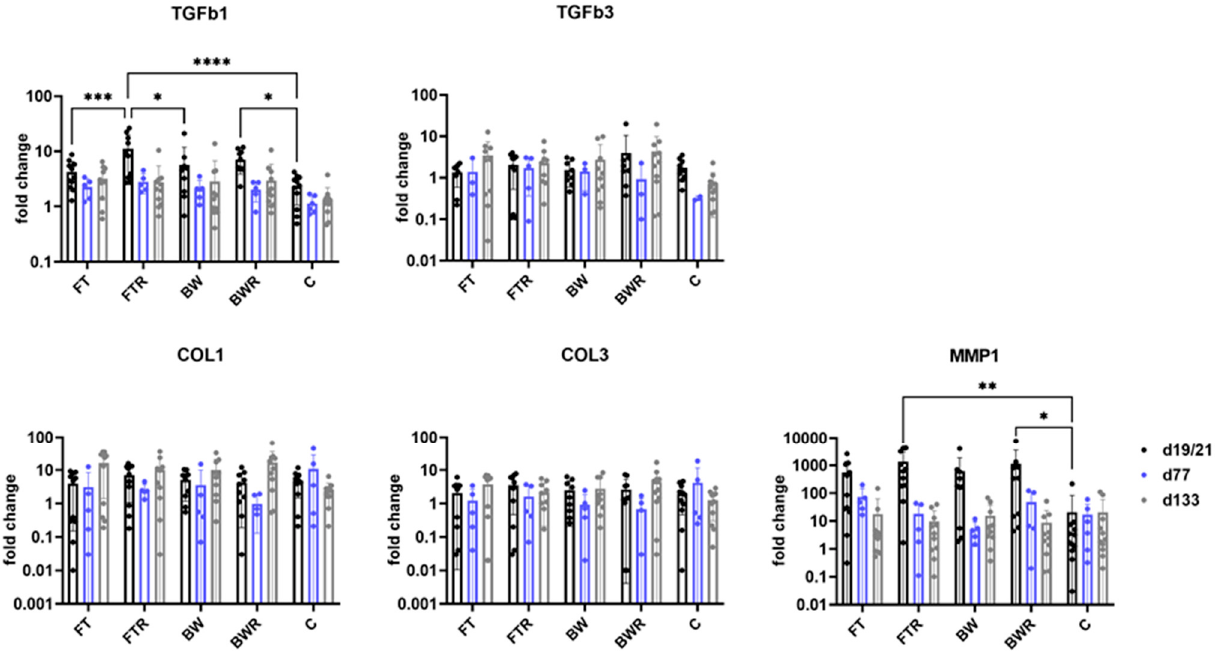
Figure 6. Resiquimod induction increased the expression of TGFb1 and MMP1. The highest expression was observed in FTR wounds. The other remodeling factors TGFb3, COL1 and COL3 showed no significant differences at the time points examined. The relative mRNA expression levels of TGFb1, TGFb3, COL1, COL3 and MMP1 were determined by qPCR, with target gene expression normalized to the averaged expression of the housekeeping gene YWHAZ. Data are presented as mean (bars) + standard deviation (whiskers). Statistical significance was determined using the two-way ANOVA and corrected for multiple comparisons using Tukey’s method. * p < 0.05, ** p < 0.01, *** p < 0.001, **** p < 0.0001, C = Control, FT = Full-thickness, FTR = Full-thickness with resiquimod, BW = Burn wound, BWR = Burn wound with resiquimod.